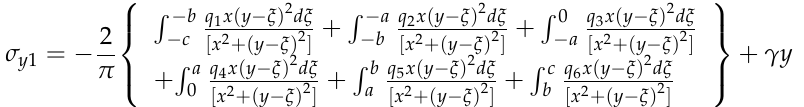
, and y is the coal seam spacing.